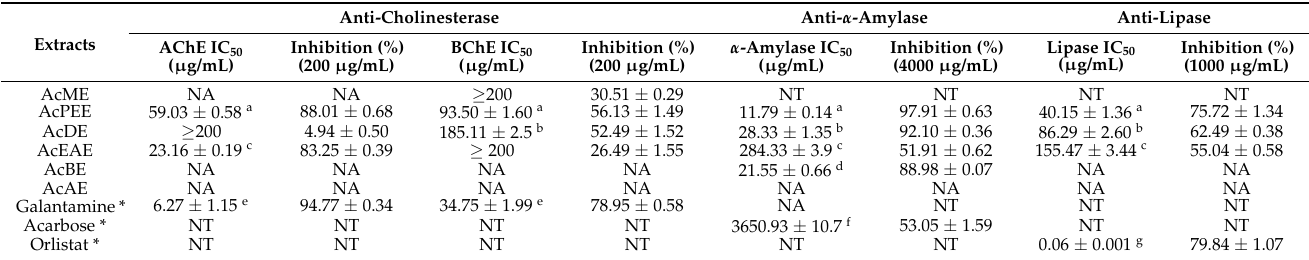
Table 6. Anti-Cholinesterase. Anti- α -Amylase. Anti-Lipase activities of different extracts of A. campestris .